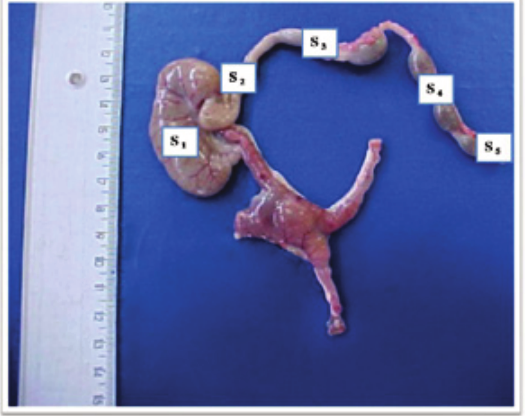
FIGURE 2 - Anatomic segment removed from animal 6 of the operated group showing the segments of the large intestine (S